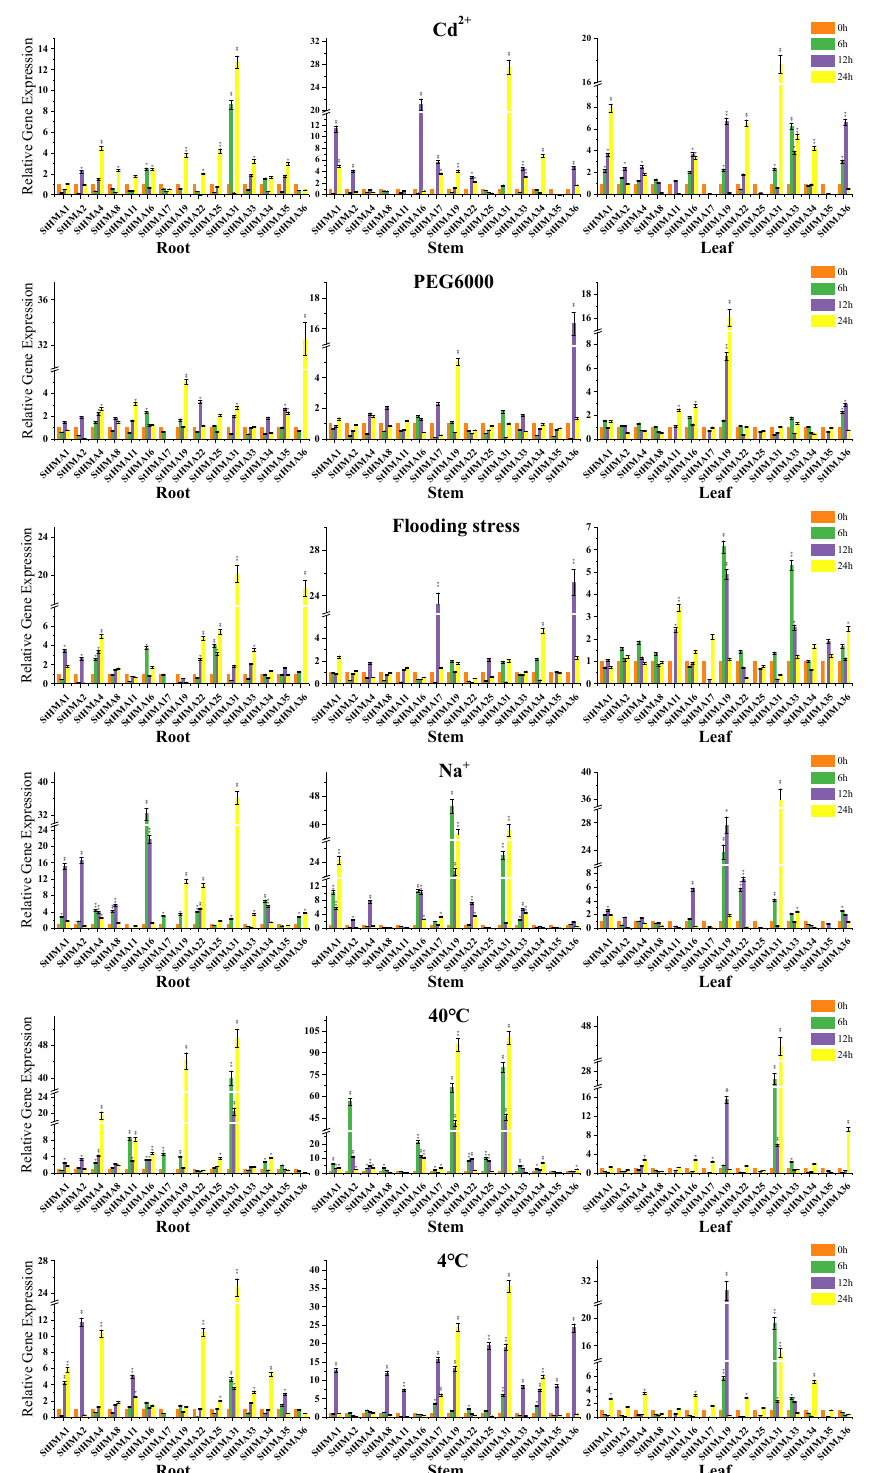
Figure 9. Expression profiles of 15 selected StHMA s in response to 40 °C, 4 °C, 30% PEG6000 (mass ratio), 25% NaCl (mass ratio), and 1g/L CdCl 2 stresses in 2-months old potato seedlings after treatment for 6, 12, and 24 h. Data represent means ( ± SD) of three biological replicates. Vertical bars indicate standard deviations. Asterisks indicate corresponding genes significantly upregulated or downregulated between the treatment and control (n = 15, * p < 0.05; ** p < 0.01; Student’s t -test).